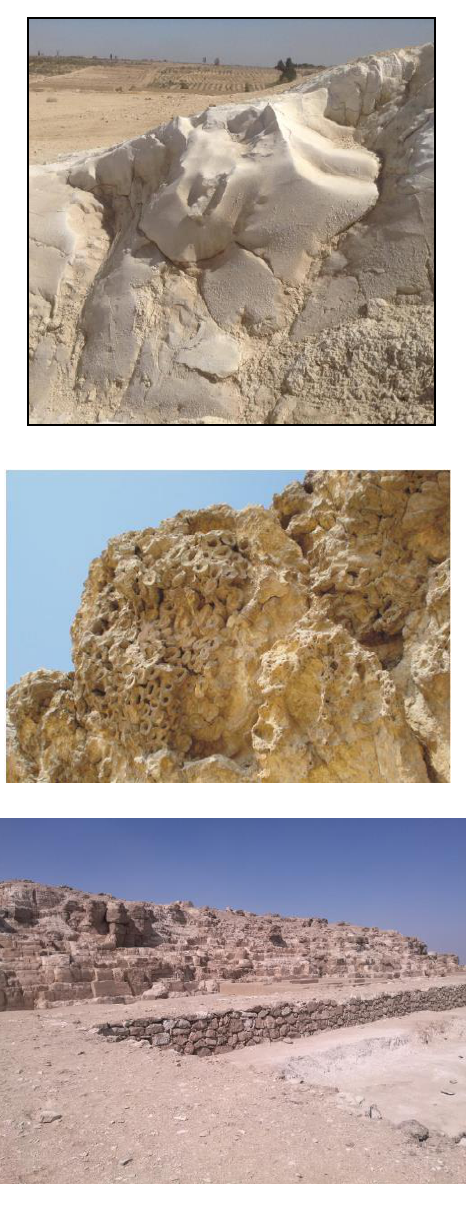
Figure 13: The lost pyramid, the Djedefre pyramid. The remaining blocks of the Pyramid.